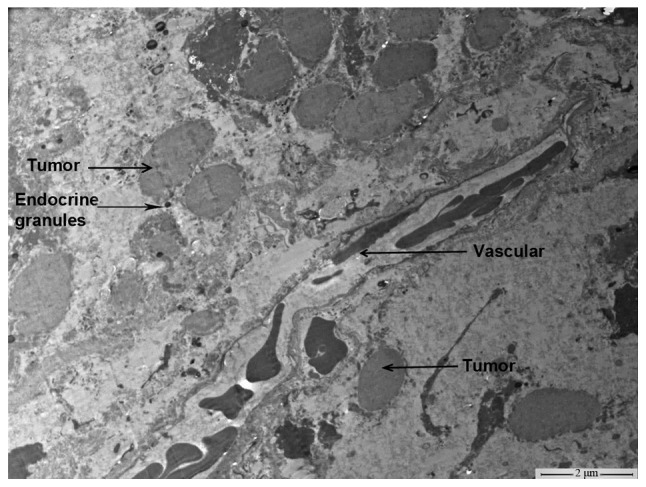
Ultra-electron microscope image of a pituitary stalk demonstrating the invasion of a tumor.